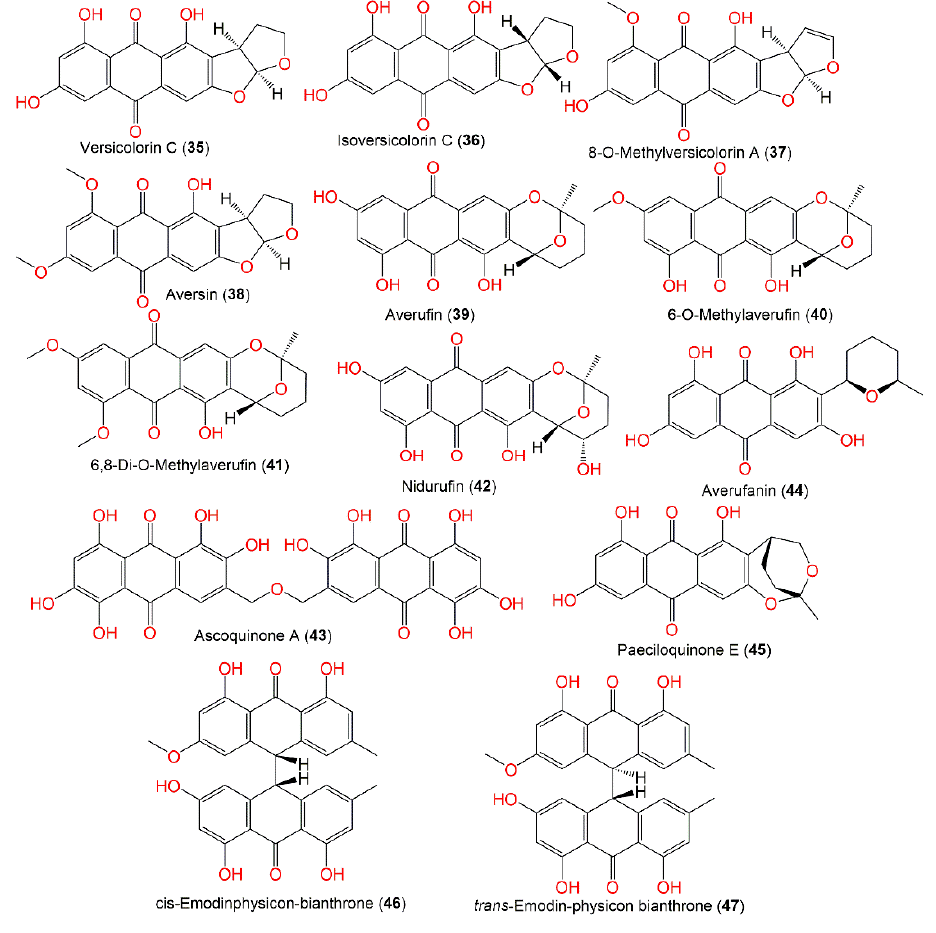
Figure 4. Structures of quinones ( 35 – 47 ).